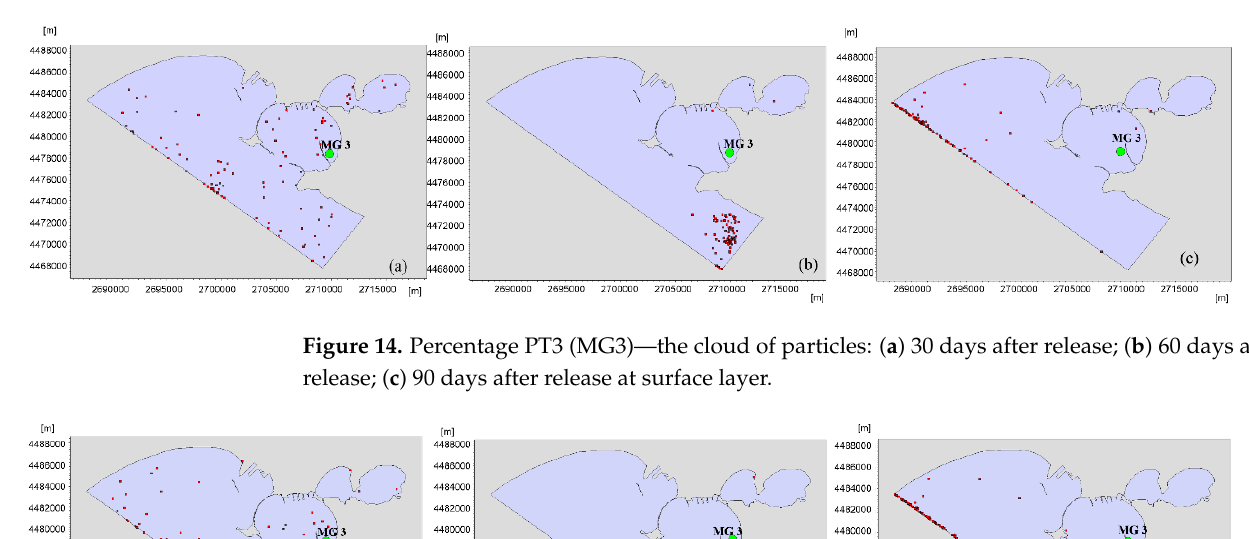
Figure 14. Percentage PT3 (MG3) — the cloud of particles: ( a ) 30 days after release; ( b ) 60 days after release; ( c ) 90 days after release at surface layer.